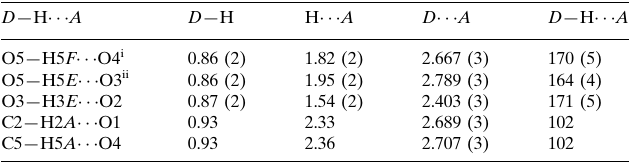
Hydrogen-bond geometry (A˚ , (cid:1)